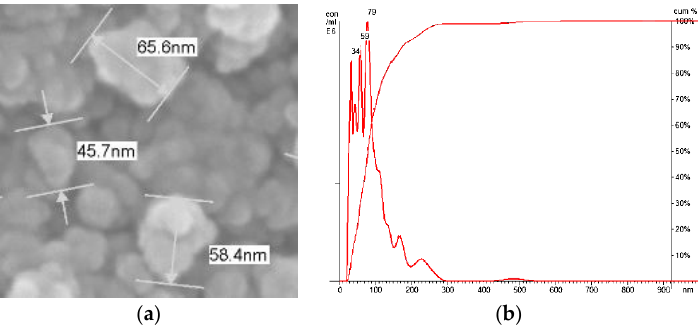
Figure 2. ( a ) Scanning electron microscopy (SEM) image of Ag/Fe 3 O 4 nanoparticles (NPs); and ( b ) size distribution of Ag/Fe 3 O 4 NPs between 34 nm and 79 nm by nanoparticle tracking analysis and NanoSight